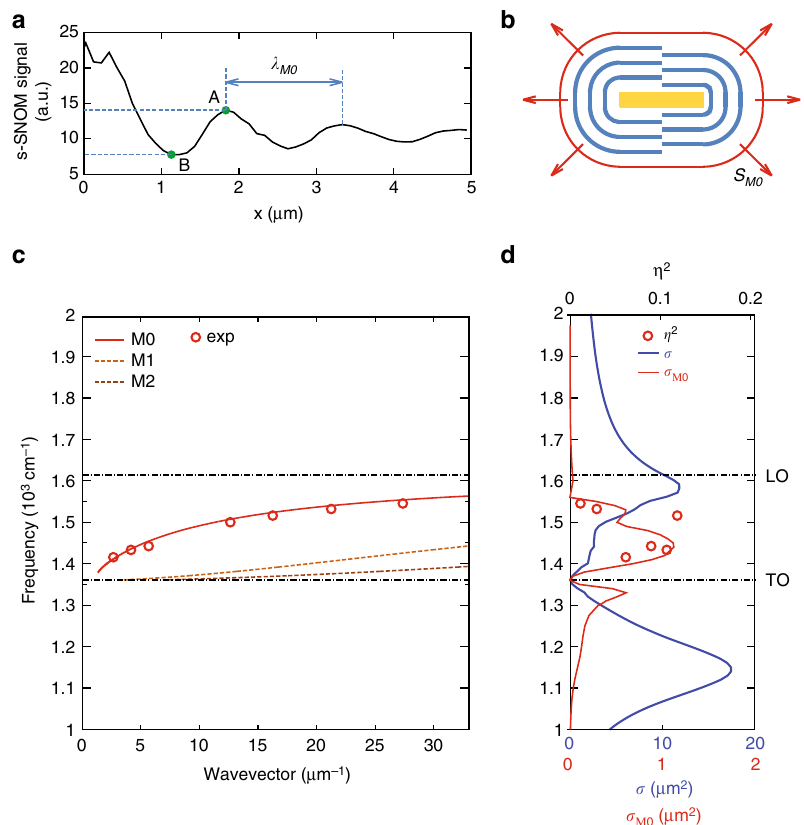
Fig. 5 Launching ef fi ciency of HPhPs by gold antennas. a Line scan along the green line in the near- fi eld image of Fig. 4e. b Schematics of the launched HPhPs wavefronts (blue lines) and the Poynting vector integration contour (red line). c The dispersion of the fi rst three HPhPs modes in the h-BN slab on top of CaF 2 . The red dots represent the measured dispersion (extracted 2 π / λ M0 ) from the line scans similar to a , taken at different frequencies. d The simulated launching cross-section for the resonant Au antenna, σ M0 (red solid curve), and its extinction cross section, σ (blue solid curve). The red dots render the launching ef fi ciency for the resonant antenna extracted from the line scans similar to the one shown in a